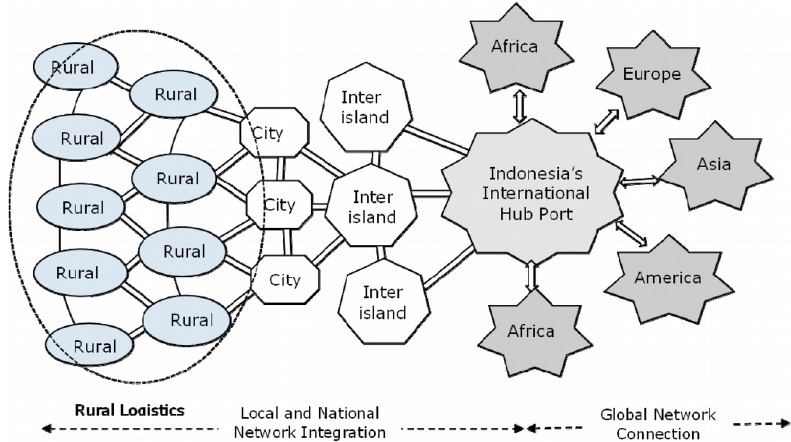
Figure 5. Indonesia Blueprint of National Logistics